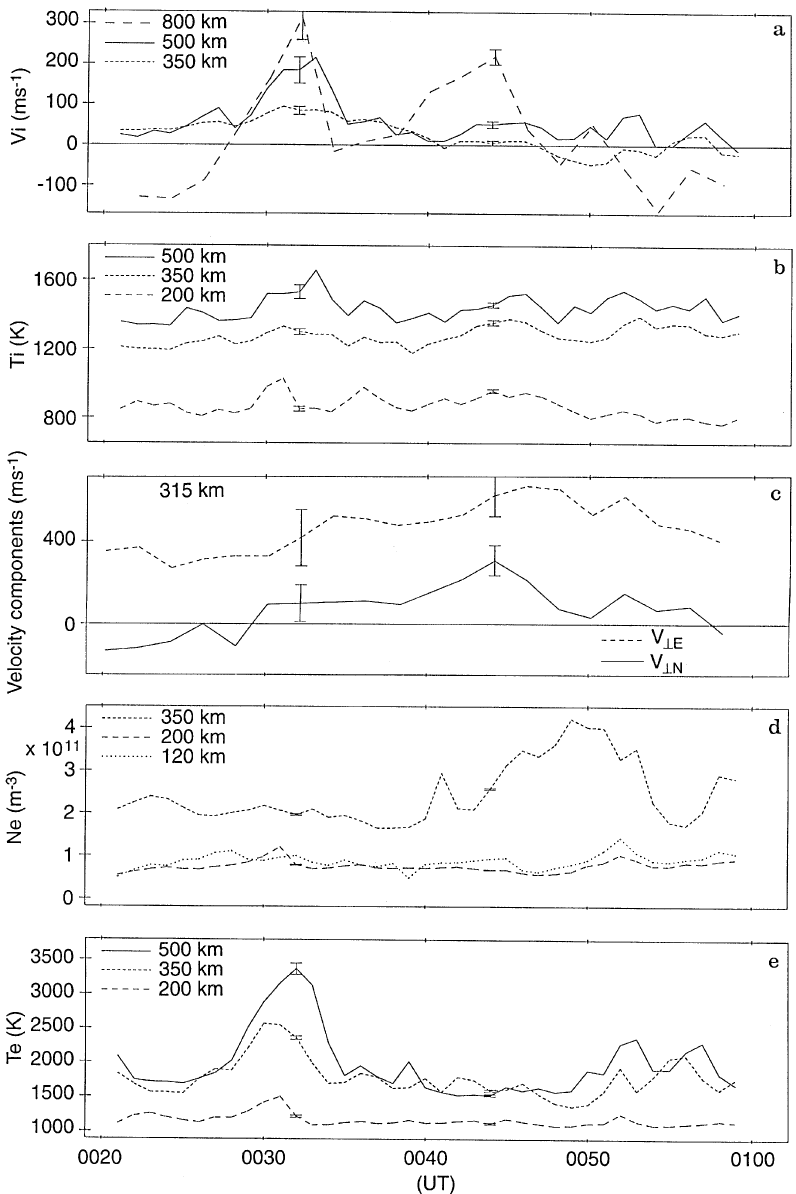
Fig. 3. Same as Fig. 2 but for 0020 — 0130 UT on 18 January